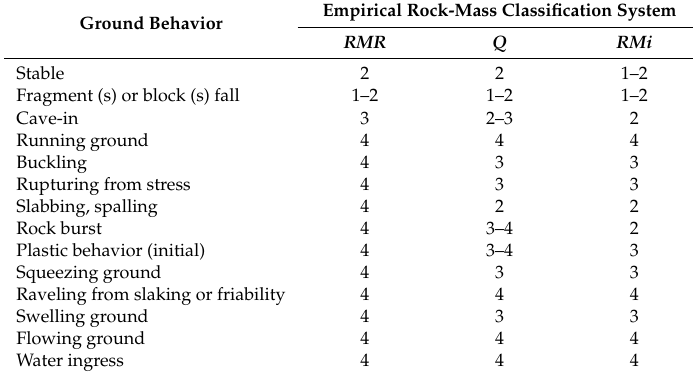
Table 8. The fitness of empirical rock-mass classification systems for different ground behavior during tunnel